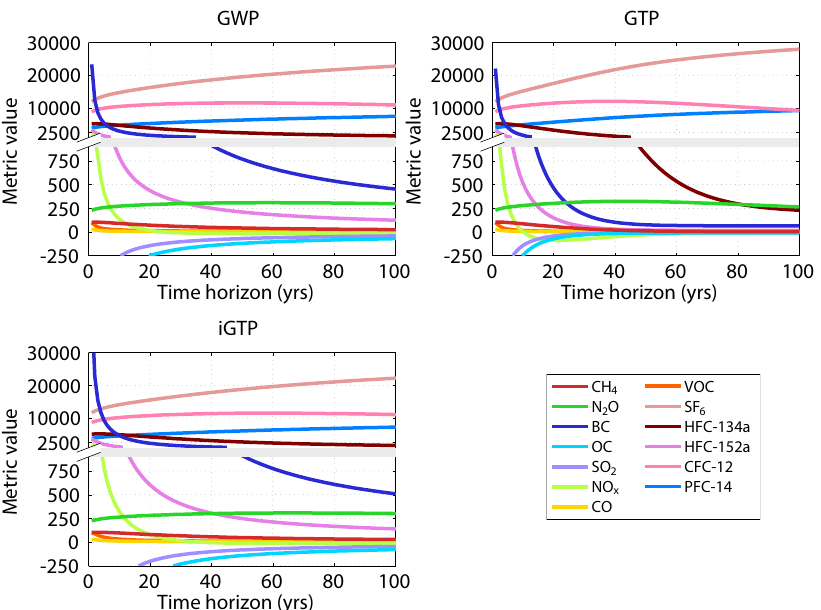
Fig. 8. GWP, GTP, and iGTP values for a range of pollutants and time horizons, the split in the vertical axis represents a change of scale at 900. The variable time horizon for these metrics GWP( H - t ), GTP( H - t ), and iGTP( H - t ), are found by reversing the time horizon axis.